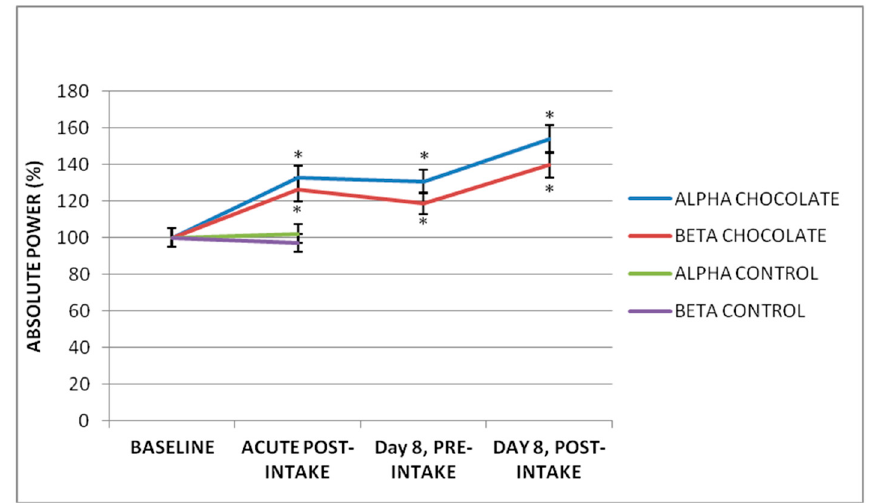
Figure 3. Effects of dark chocolate intake on the AP of the EEG bands in the O1-AVR lead. A significant increase in the Alpha and Beta bands was observed on the first day, after its daily intake for seven days and finally after the last intake at day eight (* p < 0.05, n = 20, ANOVA-test). In the control group, no significant changes were observed ( p > 0.05, n = 5, T -test).